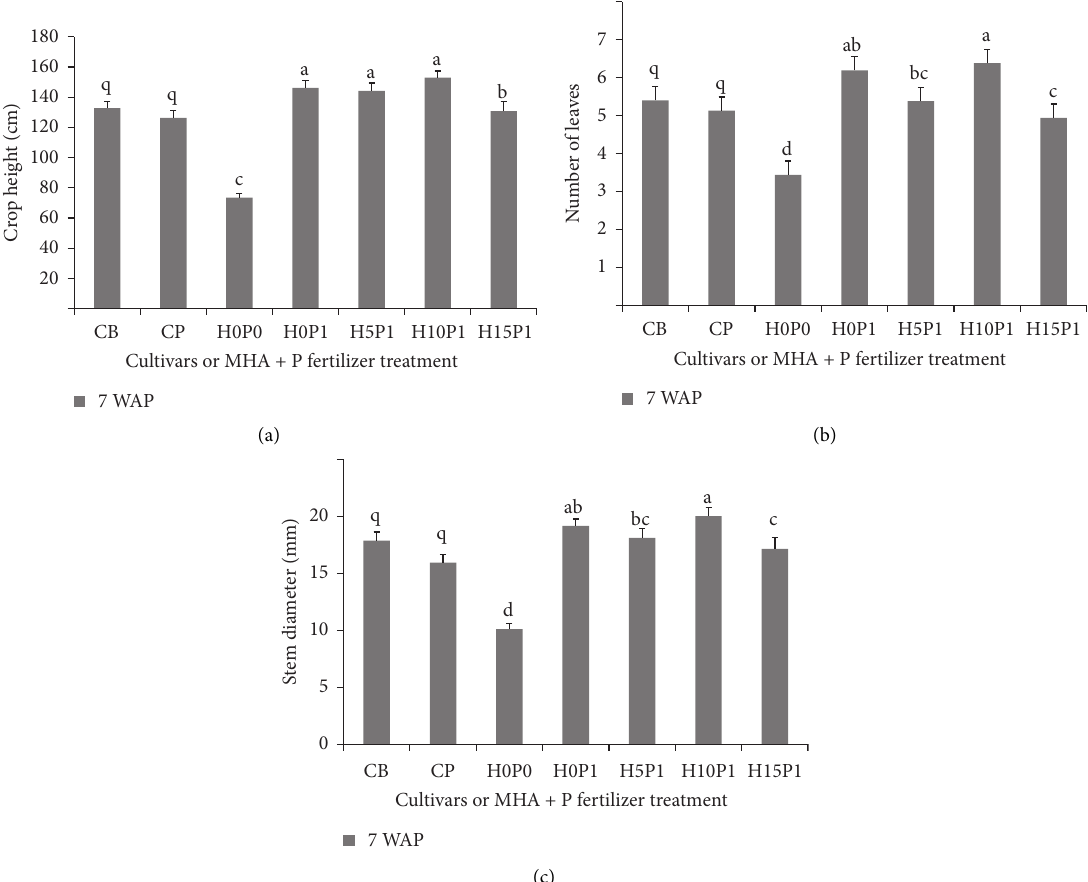
Figure 4: Crop height (a), number of leaves (b), and stem diameter (c) 7 weeks after planting (WAP). CB is Bisi 2 hybrid corn, CP is Pioneer 35 hybrid corn. H 0 P 0 is the control, H 0 P 1 is 0mg kg − 1 composted manure (MHA)+P fertilizer, H 5 P 1 is combined 35mg kg − 1 MHA+P fertilizer, H 10 P 1 is combined 75mg kg − 1 MHA +P fertilizer, and H 15 P 1 is combined 110mg kg − 1 MHA +P fertilizer. The rate of P fertilizer in each P 1 treatment was equivalent to 120 mg P 2 O 5 kg − 1 air-dried soil. Values followed by the same lowercase letter in a column were not significantly different based on Duncan’s multiple range test at p < 0 . 05. The results presented are the mean+standard error of 3